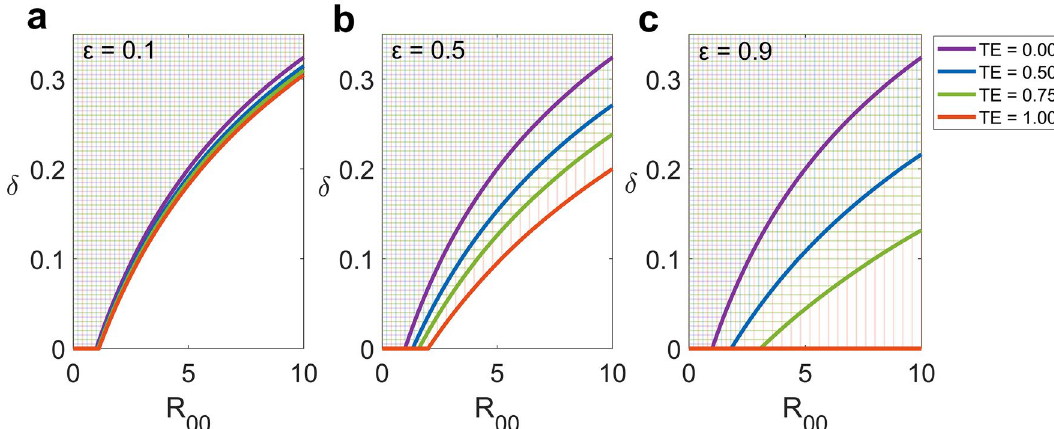
Figure 4. Transmission-controllable area. The transmission-controllable area (hatched areas above the lines) illustrates sets of parameters corresponding to the control of transmission with R 0 < 1 . The solid line represents the R 0 = 1 line separating the controlled (above) from the uncontrolled (below) areas. Different treatment efficacies ( TE ) are shown with different colours. Transmissions with ε = 0.1 , 0.5, and 0.9 are depicted in ( a ), ( b ), and ( c ),